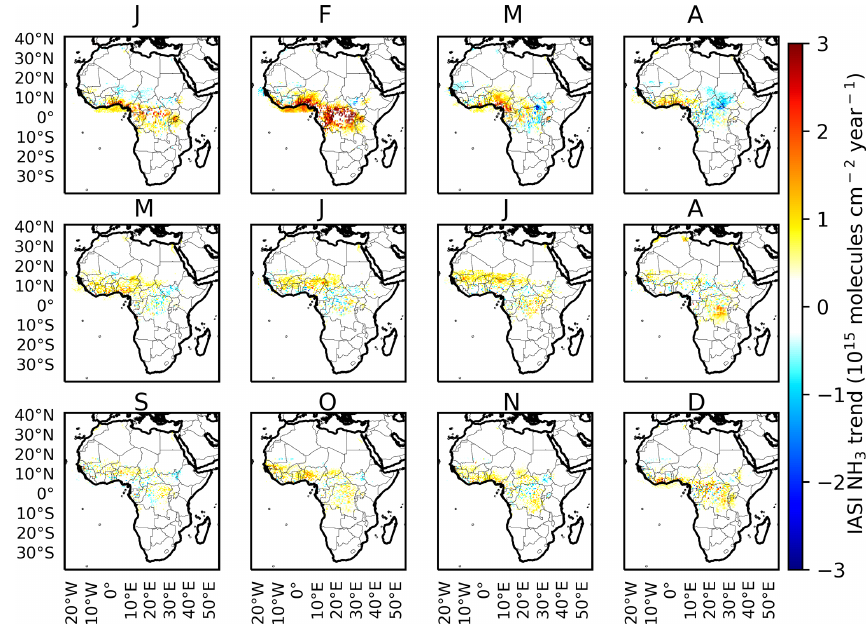
Figure 3. Change in mean monthly atmospheric NH 3 VCDs for the period 2008 through 2018. Grid cells where mean annual NH 3 VCDs for the entire period are under 5 × 10 15 molecules cm − 2 are not displayed. Results significant at P = 0 . 05 are presented in Fig. S5.